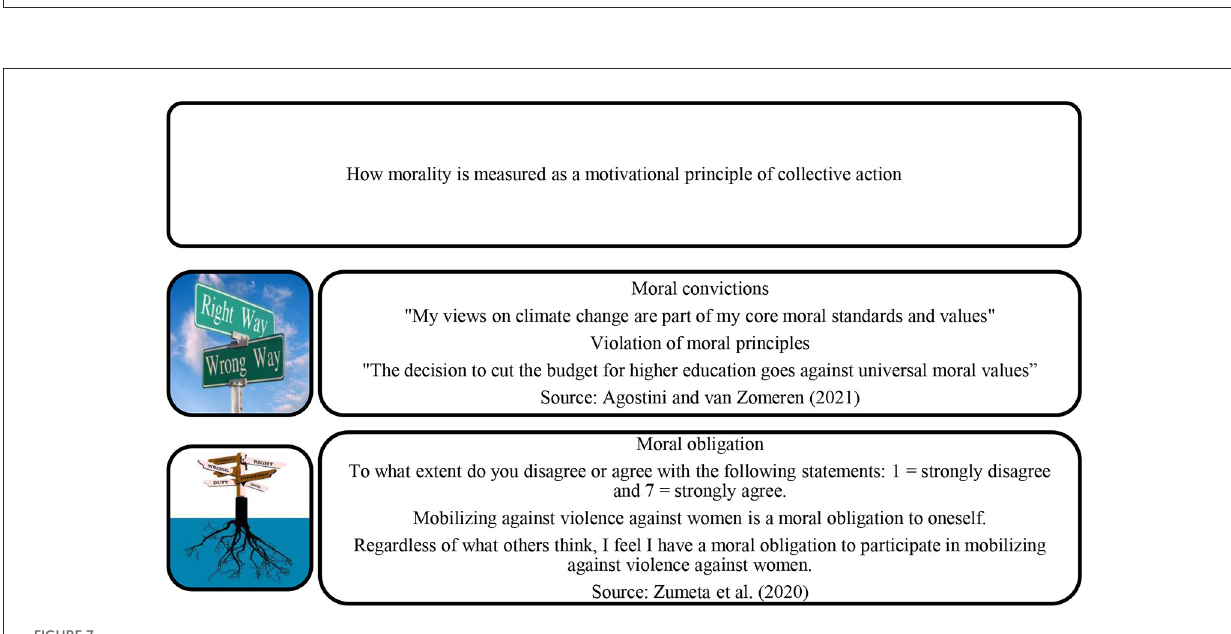
FIGURE7 Measures of moral conviction and